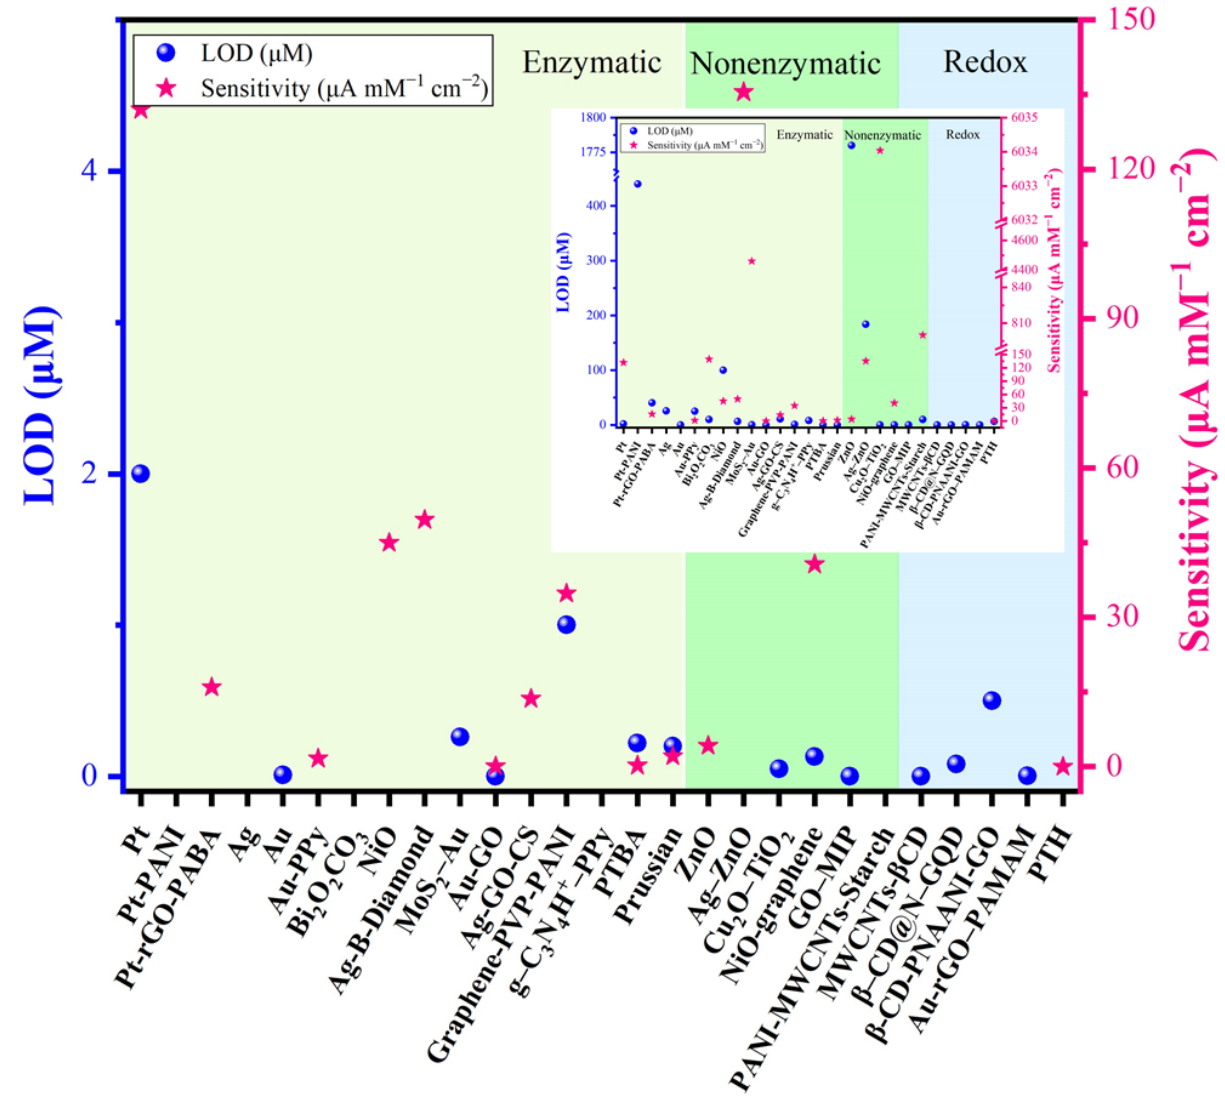
Figure 10. Comparison of sensitivity and limit of detection (LOD) of nanomaterial-based cholesterol sensors. (Note: More details about the various sensors can be found in Table 1).